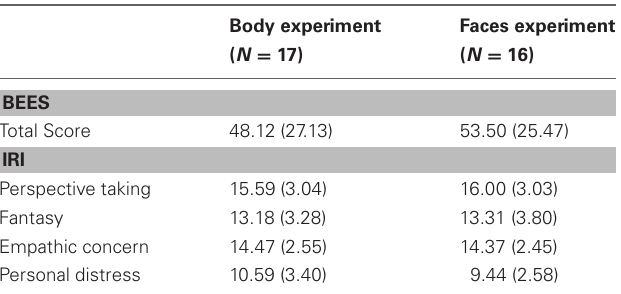
Table 2 | Mean scores (standard deviations) on the Balanced Emotional Empathy Scale (BEES; Mehrabian and Epstein, 1972) and on the abbreviated German version of the Interpersonal Reactivity Index (IRI, Paulus, 2007), calculated separately for the participants in the body and in the face